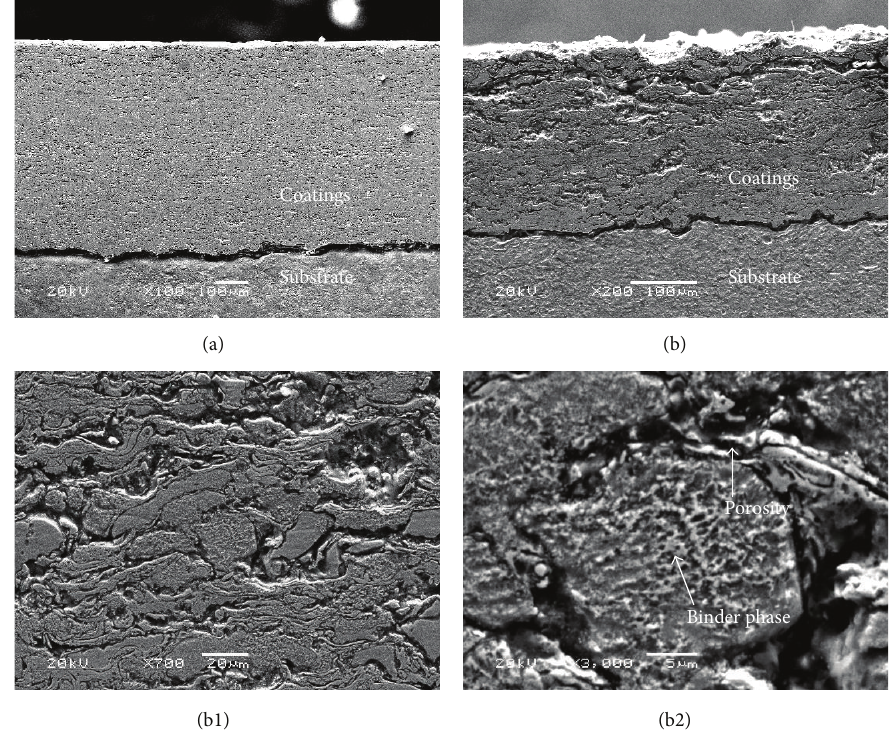
Figure 4: Microstructure of the coatings produced with different percentages of composite powders. (a) Ni45-hBN, 5 wt.% h-BN; (b) Ni45- hBN, 10 wt.% h-BN; (b1), (b2) high magnification structure of 10wt.% h-BN coating.